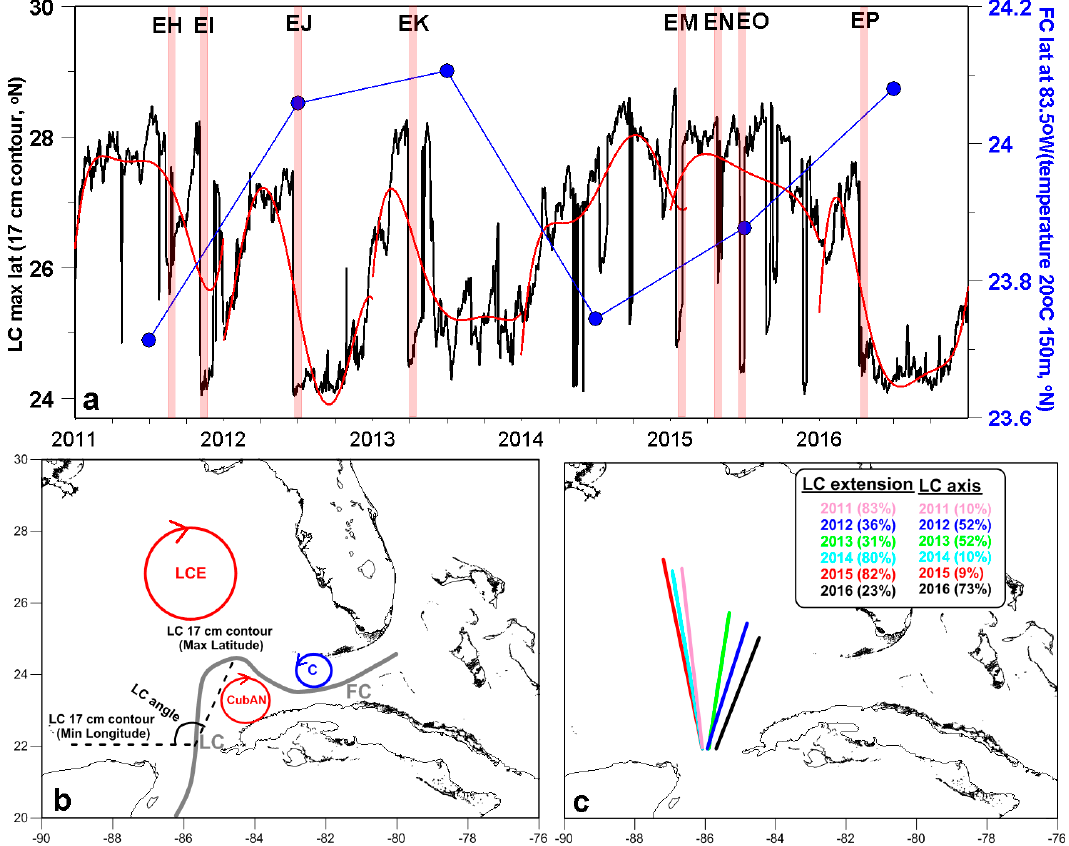
Figure 3. ( a ) Daily evolution of the maximum latitude ( ◦ N; black line) of the Loop Current (LC) defined by the 17 cm Sea Surface Height (SSH) contour and annual means of the Florida Current (FC) latitude ( ◦ N; blue line) as derived from the location of the 20 ◦ C temperature contour line at 150 m along the 83.5 ◦ W meridian (Section 1 in Figure 1a). The red shaded boxes indicate the major LC Eddy (LCE) detachments (Eddies Hadal: EH; Icarus: EI; Jumbo: EJ; Kraken: EK; Michael: EM; Nautilus: EN; Olympus: EO; Poseidon: EP). The red line indicates the 5th order annual polynomial fit of the LC time series. ( b ) Sketch of the definition of the LC axis and angle (dashed lines), showing the position of characteristic circulation features (LC, FC, anticyclonic eddies: LCE, CubAN, and a cyclone: C in the Straits of Florida). ( c ) Annual mean values of the LC axis angle for the 2011–2016 period. The annual frequency (%) of the LC extension and of the LC axis angle being larger than the respective long-term averages (LC mean extension = 26.25 ◦ N and LC mean axis = 100 ◦ ), derived for the entire period (2011–2016), are also presented in ( c